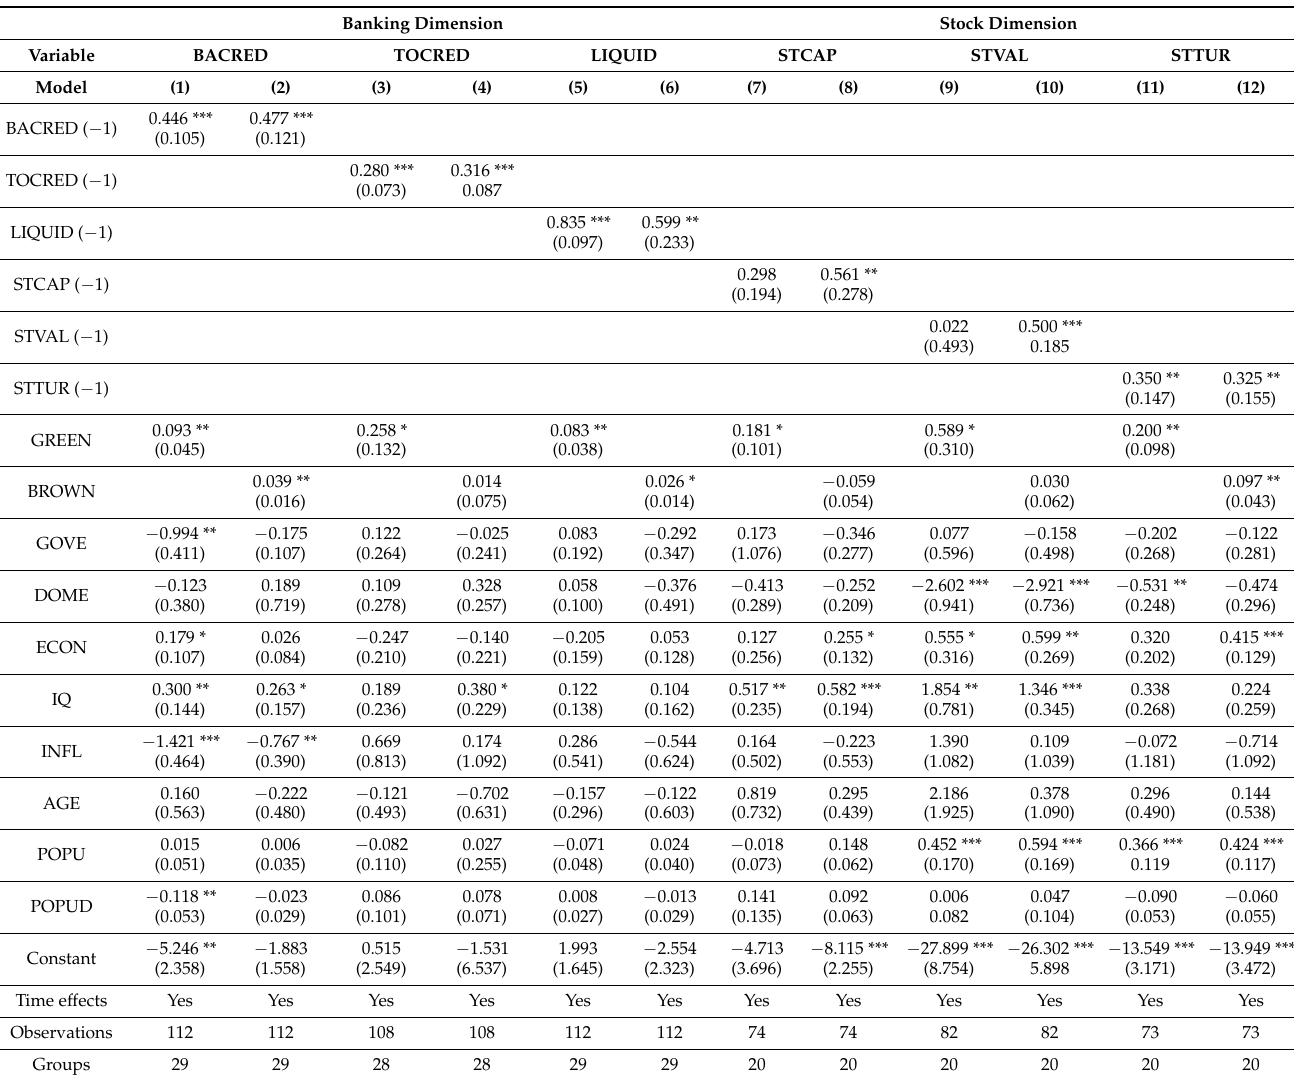
Table 9. The regression results of the impact of greenfield and brownfield FDI on financial develop-